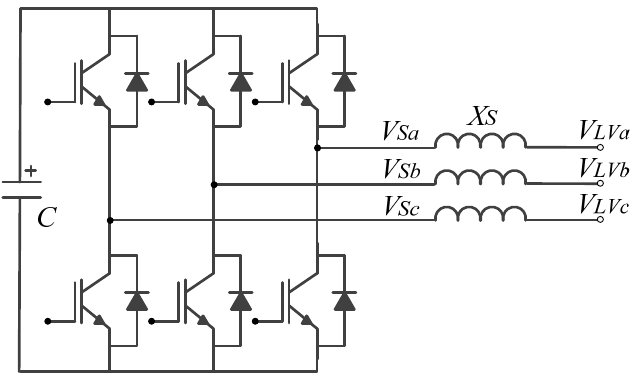
Figure 9. Typical scheme of a STATCOM based on VSI, voltage source